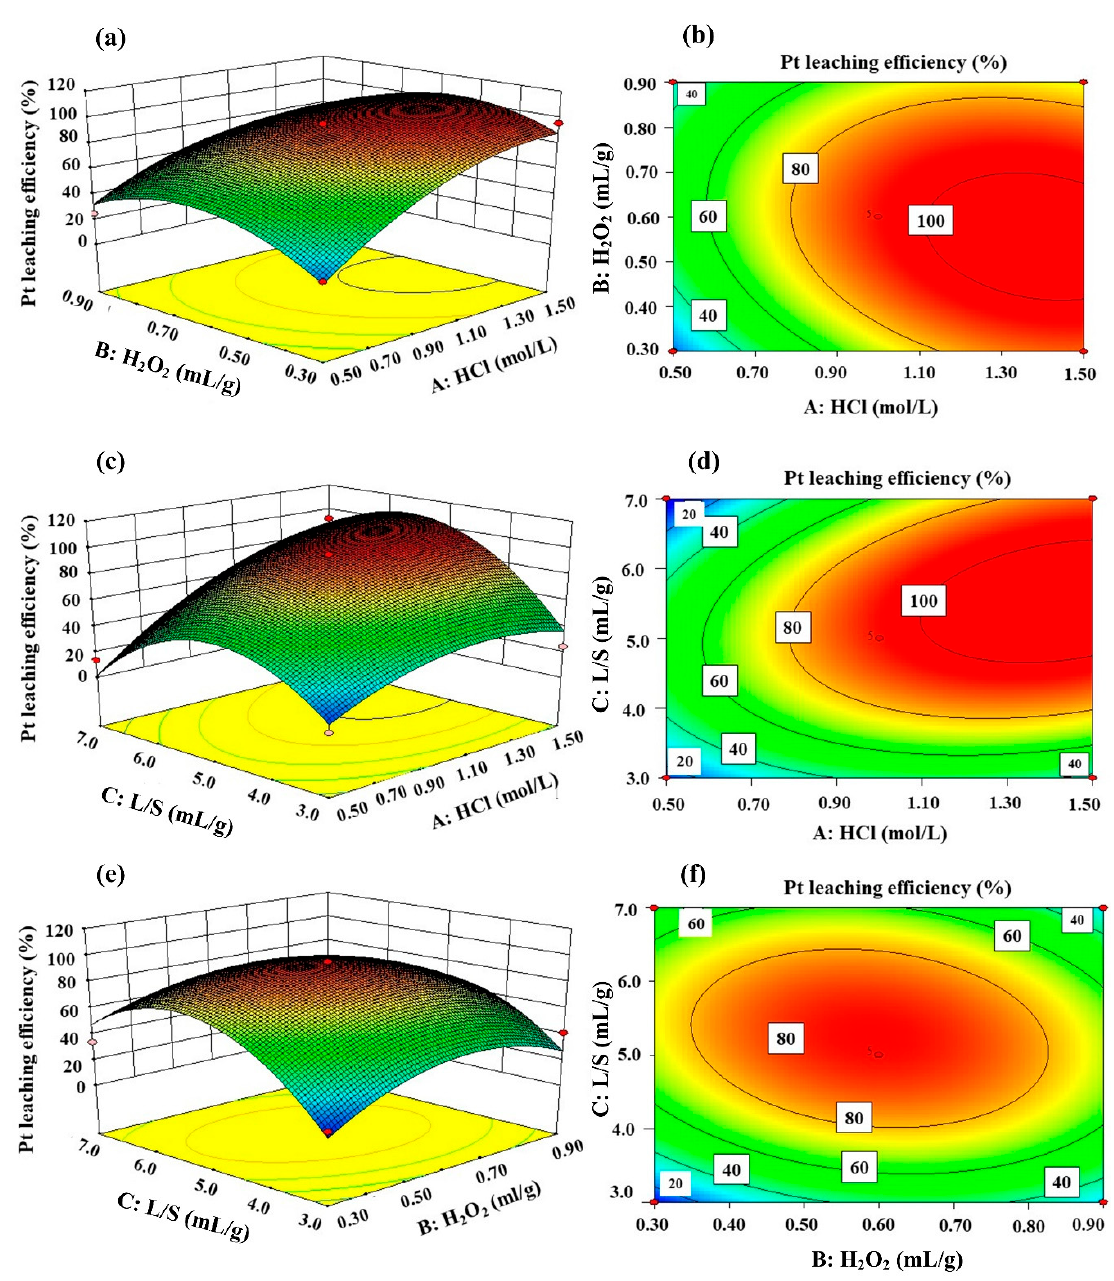
Figure 11. The 3D response surface and 2D contour plots for the interaction effects on the platinum leaching rate. In ( a , b ), C: L/S = 5.0 mL/g; in ( c , d ), B: 10% H 2 O 2 /spent catalysts = 0.6 mL/g; and in ( e , f ), A: c(HCl) = 1.0 mol/L.